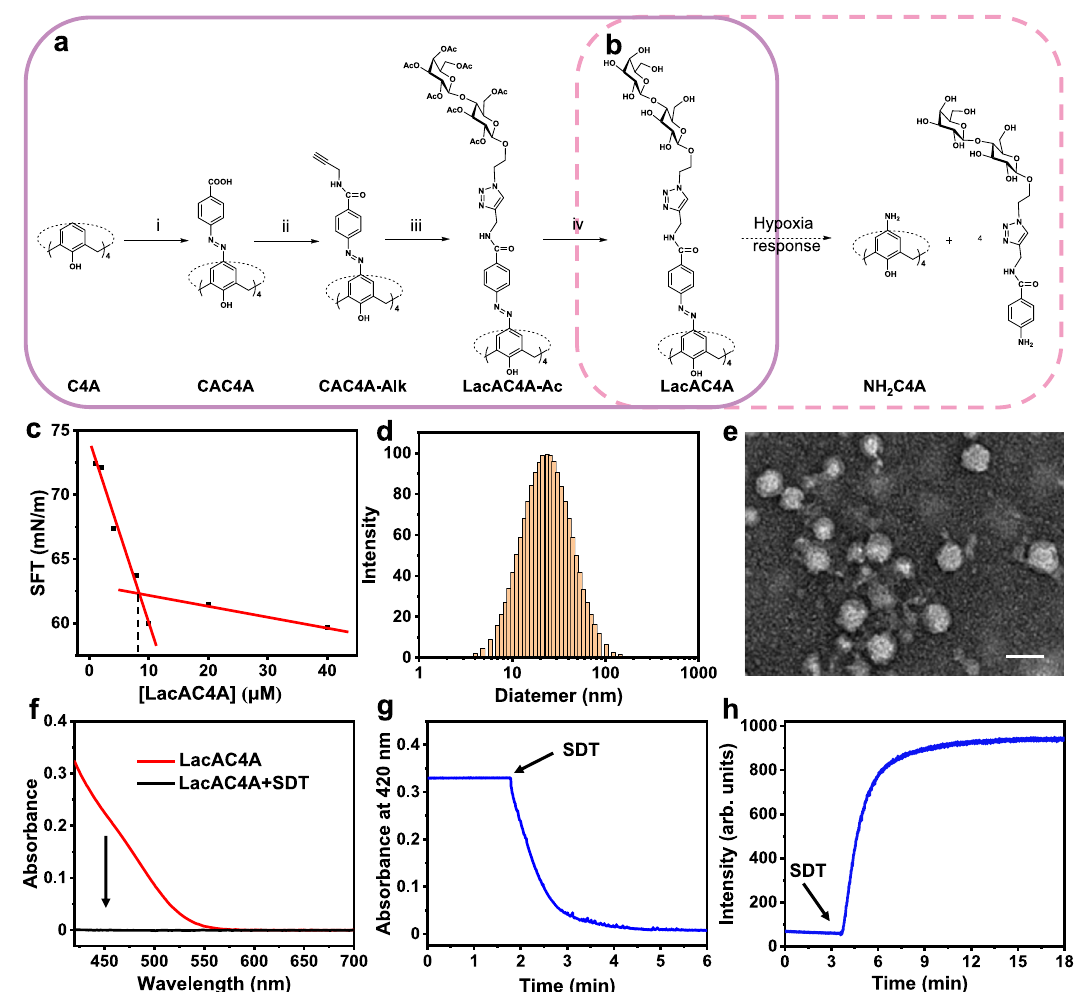
Fig. 2 | Synthesis, characterization, and hypoxia responsiveness of LacAC4A. a Synthetic route of LacAC4A: (i) NaNO 2 , HCl, 0 – 5°C; (ii) Propargyl amine, 2-(7-azabenzotriazol-1-yl)- N,N,N ’ ,N ’ -tetramethyluroniumhexa fl uorophosphate, N,N - diisopropylethylamine, rt; (iii) Lac-N 3 , tetrahydrofuran/H 2 O, CuSO 4 ·5H 2 O, L-ascorbicacidsodiumsalt,55°C;(iv)CH 3 OH,CH 3 ONa,rt; b Thereductionreaction ofLacAC4A. c CACofLacAC4A. d DLSresultofLacAC4A(0.10mM). e